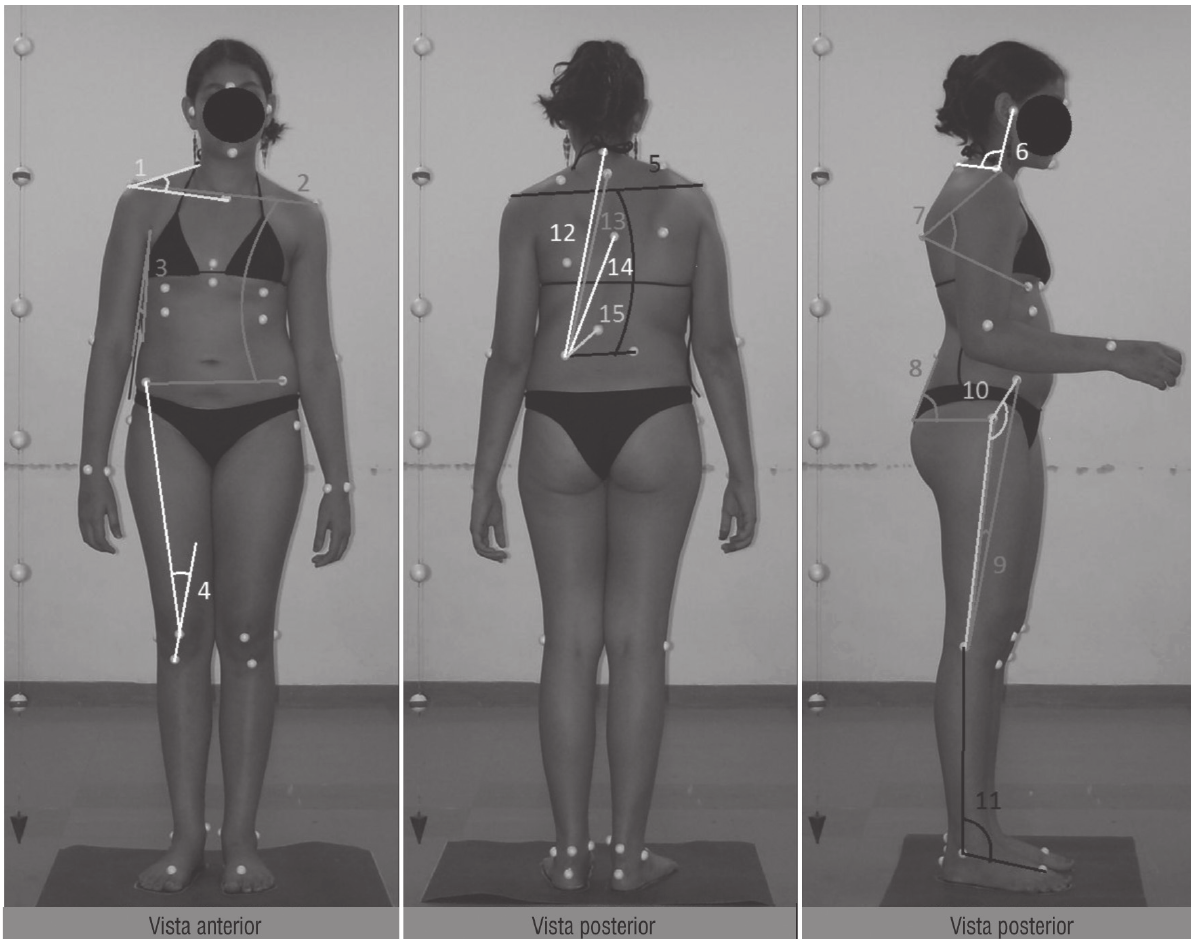
Figura 1 - Ângulos utilizados na avaliação